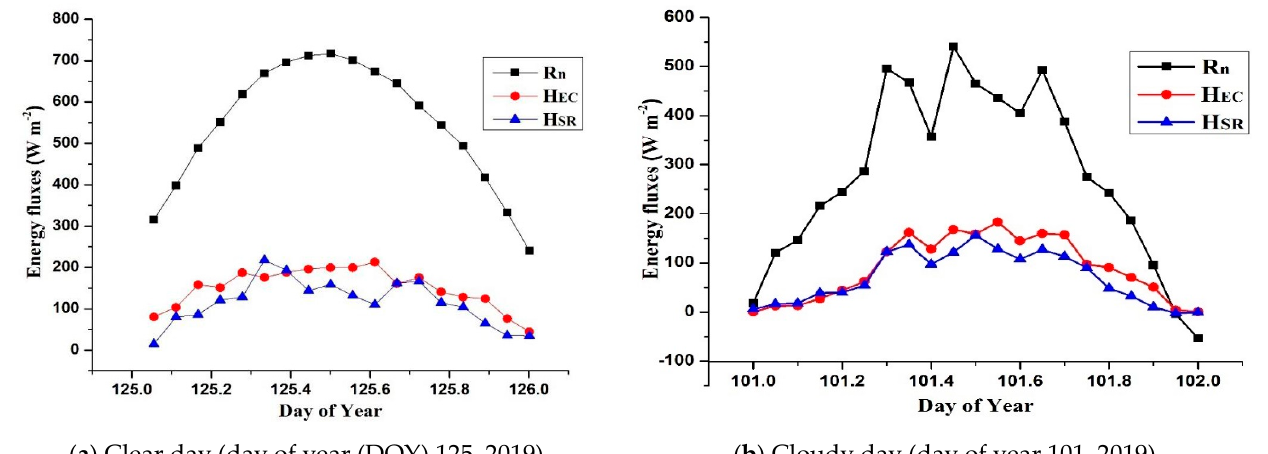
Figure 6. Diurnal variation of the half-hourly H SR , H EC , and R n ( a , b ).